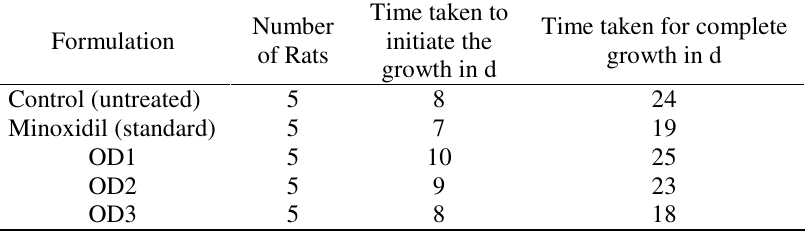
Table 4 . Qualitative observation of hair growth.